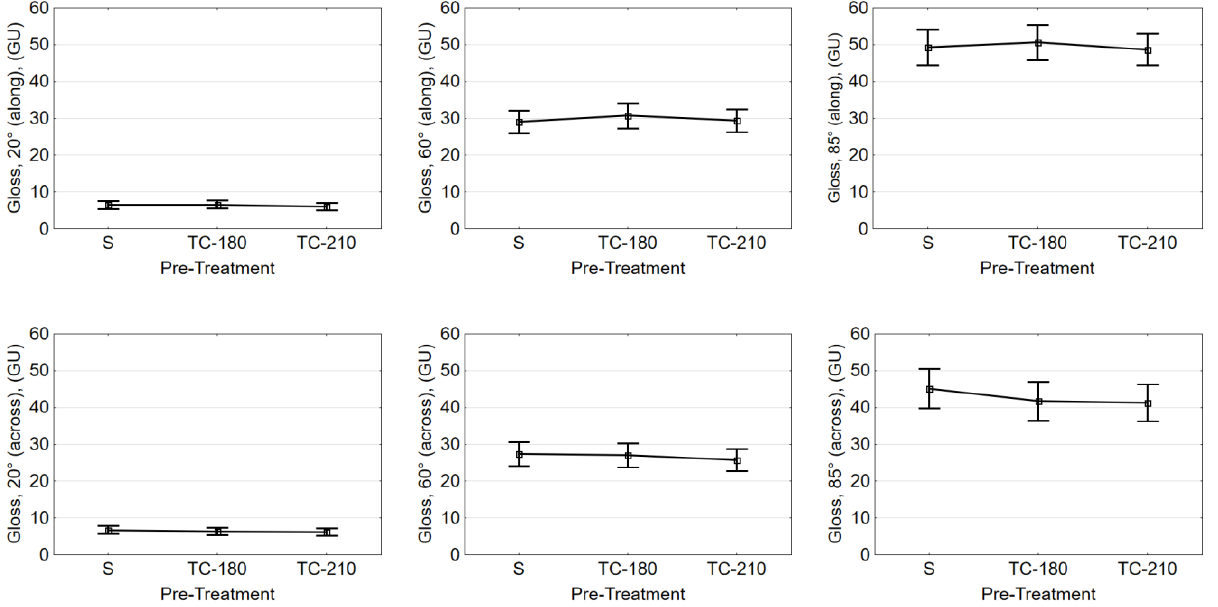
Figure 6. Main effects plot for mean gloss for different pre-treatment processes for each measure- ment angle.